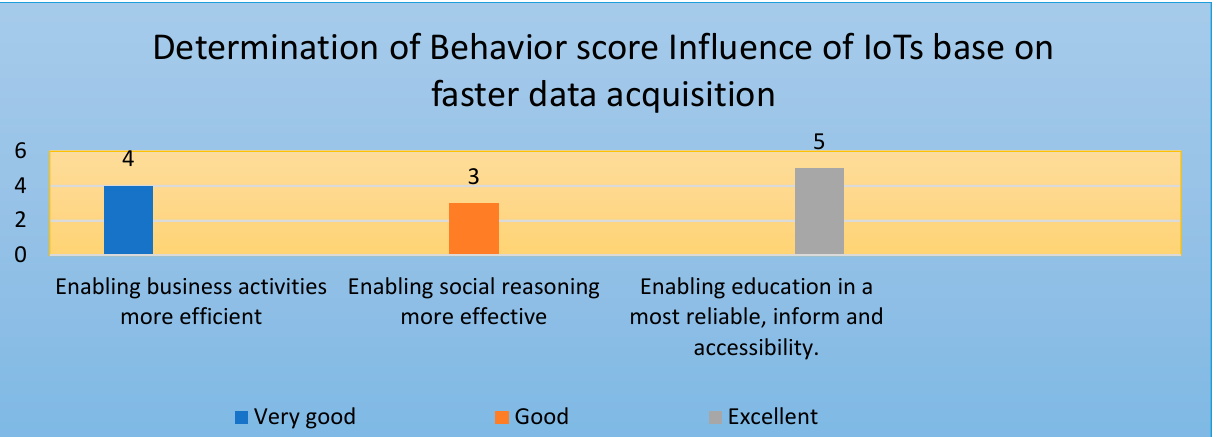
Table 4. The determination of Behavior score of Influence of IoTs based on f aster data acquisition. Push Factors IoTs